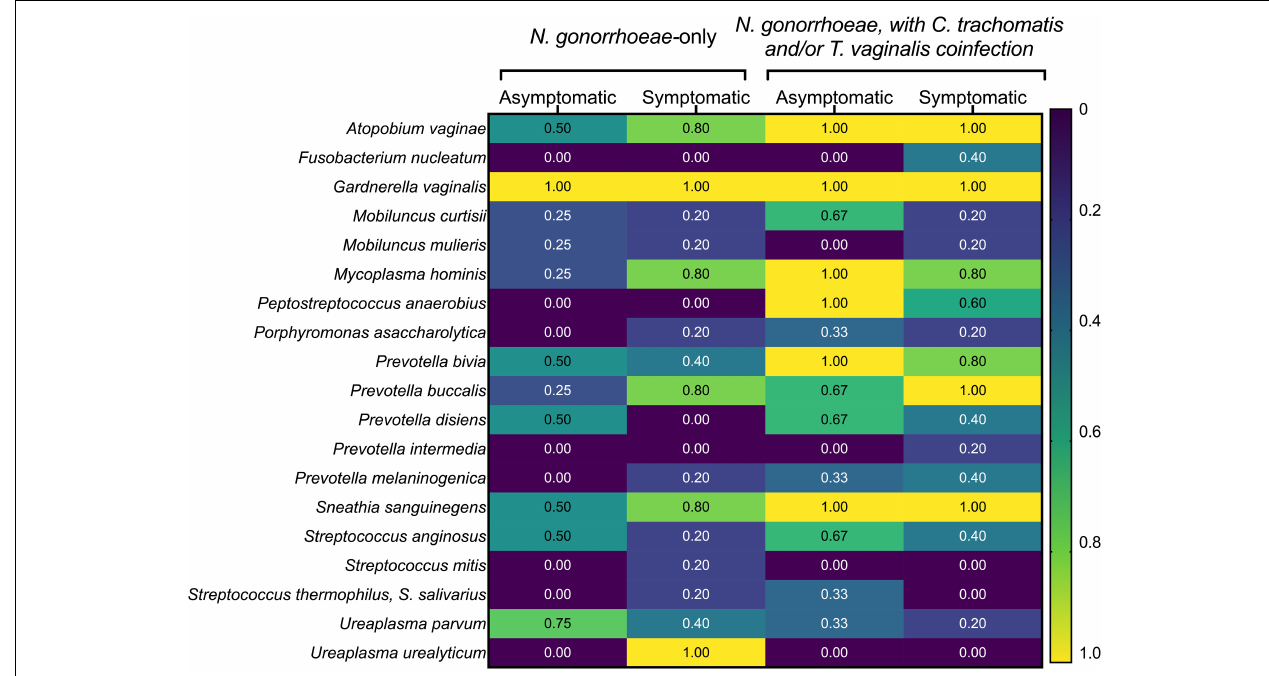
FIGURE 6 | Prevalence of common bacterial vaginosis-associated bacteria detected with commercially available microbial DNA real-time PCR assay. The presence of the indicated BV-associated bacterial species was assessed by the presence/absence of commercially available real-time PCR assay. Participants have been grouped by symptom and co-infection status. The fraction of individuals within each group positive for each of the seven BV-associated bacteria in the panel are shown as a heatmap, with values ranging from “0” (i.e., none of the women in the group positive for that species) to “1.0” (i.e., all women in the group positive for that